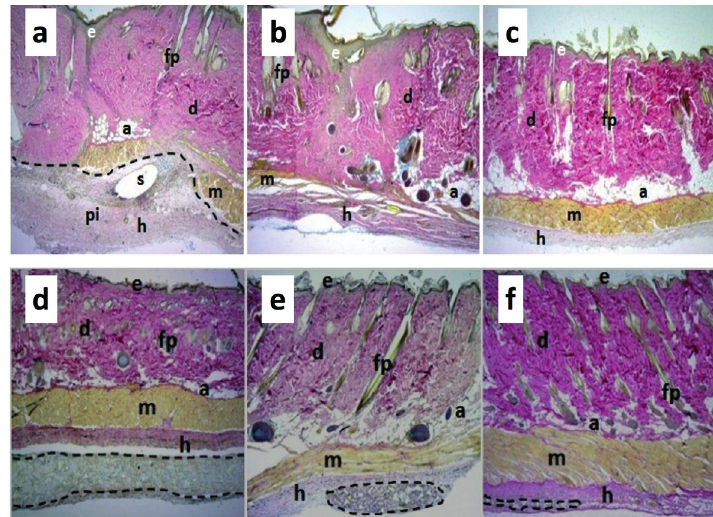
Figure 1 - Panoramic images representative of histological sections of the dorsal skin of rats at days 7, 30, or 90 after surgery in animals from the Sham ( a- c ) or PU ( d-f ) groups, stained by Vanderbilt coloring at 40X magnification. In both groups, there is intense cellularity of mononuclear and FBGC cells in the hypodermis (h) surrounding the suture (s) at peri-implant tissue (pi), indicating the inflammatory process (below the dashed line), whereas epidermis (e) and dermis (d) are intact with typical layers of adipocytes (a) and skeletal muscle (m), and the presence of hair follicles (fp) in the Sham group. ( d ) During the acute phase of the inflammatory response in the PU group, PU is intact and thick, reflecting onset of activity for FBGC surrounding it (dotted line). ( e ) At day 30, the implanted material is fragmented, probably reflecting effective macrophage depletion by FBGC and indicating intermediate healing process and tissue regeneration. ( f ) Chronic phase of the inflammatory response (day 90), with reduced cellularity (mononuclear and FBGC) involving polyurethane (dashed line) in the hypodermis, which is quite reduced and fragmented, whereas collagen fibers and hair follicles have structures that do not differ between the Sham and PU groups, indicating the end of the healing process with complete tissue